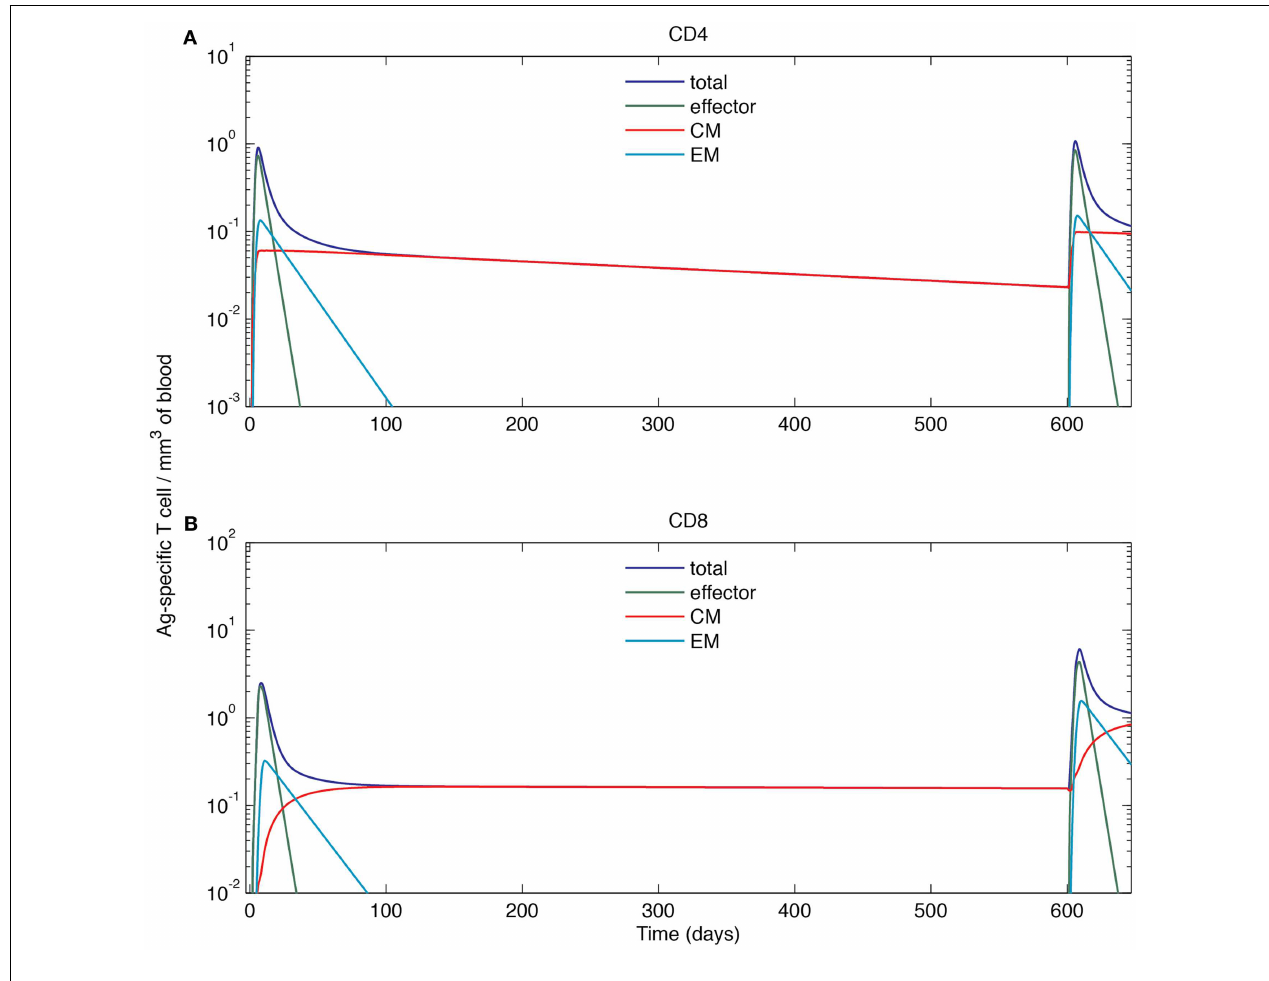
subsets in the blood. (B) Concentration of CD8 + T cells of different subsets in the blood.The left parts of the graphs are identical to those